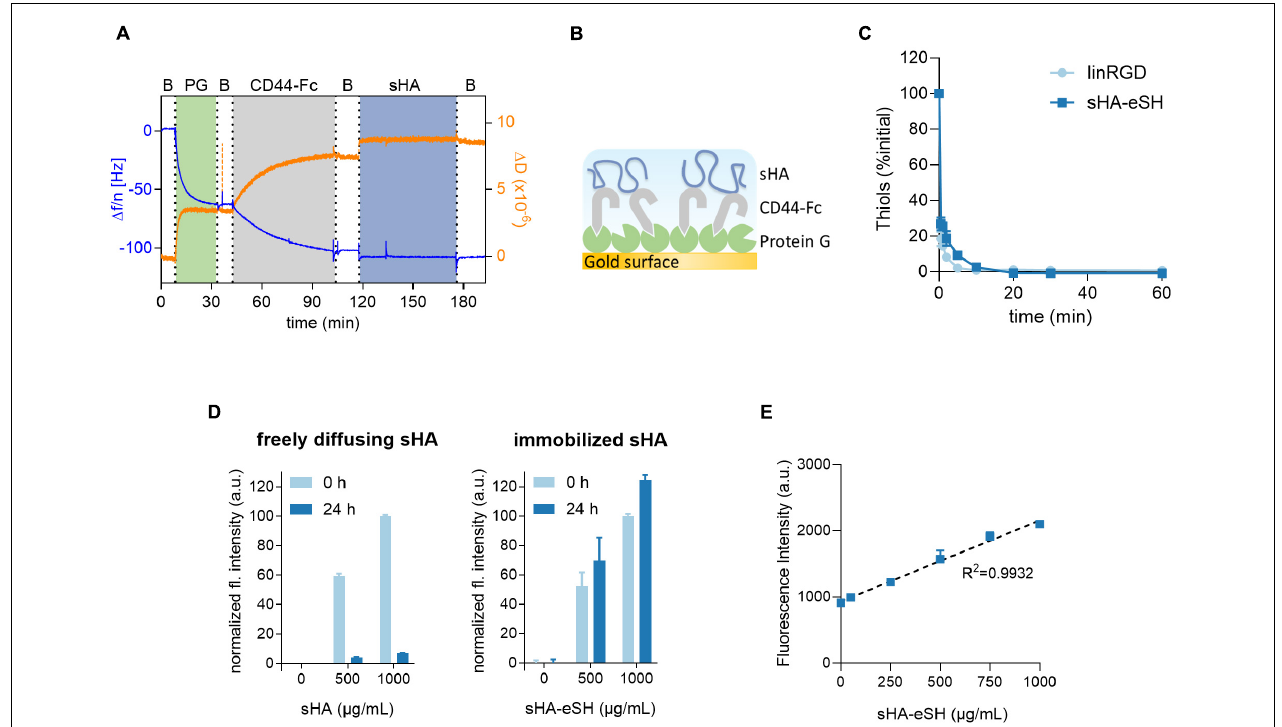
Figure 2 | (A) QCM-D measurement confirms CD44-sHA interaction. The binding experiment shows the formation of a stable adlayer of protein G (PG) on a gold surface, followed by immobilization of Fc-tagged CD44 and its binding to sHA. Data from the 7th overtone are shown, frequency changes depicted in blue and dissipation changes in orange. (B) Schematic diagram of immobilization strategy on QCM-D sensor. (C) Kinetics of thiol-Michael addition reaction of sHA-eSH and linRGD. Progression of the conjugation to 8-arm PEG-VS macromonomers was monitored over time by detecting the decrease of free terminal thiol groups; mean and standard deviation of triplicates are presented. (D) Detection of varying amounts of fluorescently-labeled hyaluronan within hydrogels after incubation in PBS for 24 h. 3.5 wt/vol% PEG hydrogels with varying amounts of fluorescent sHA (soluble sHA) or sHA-eSH (immobilized sHA) were prepared by thiol-Michael addition reaction. (E) Fluorescence intensity values of hydrogels after washing in PBS are plotted over the hyaluronan concentration per mL of hydrogel solution; mean and standard deviation of quintuplicates are